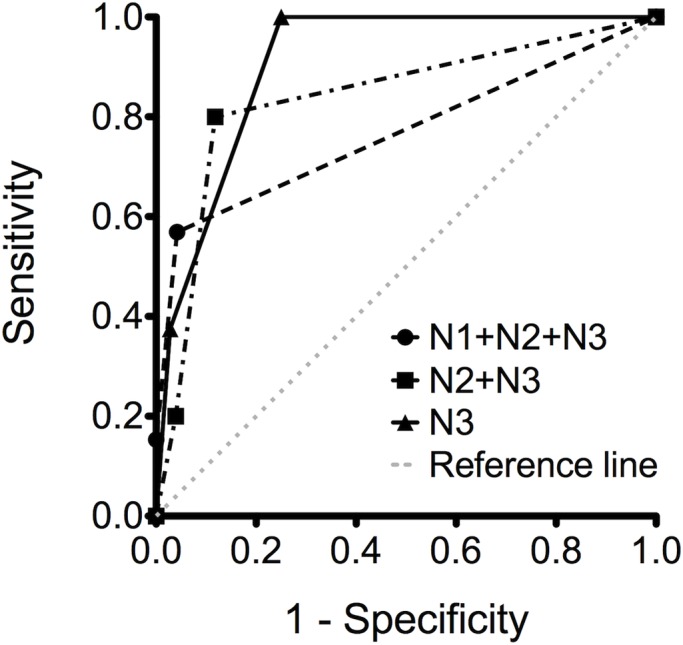
Receiver operating curves exhibiting impaired perfusion as a predictor of the varying severity of necrosis.N1 + N2 + N3 = minimal-to-massive necrosis; N2 + N3 = moderate-to-massive necrosis; N3 = massive necrosis.